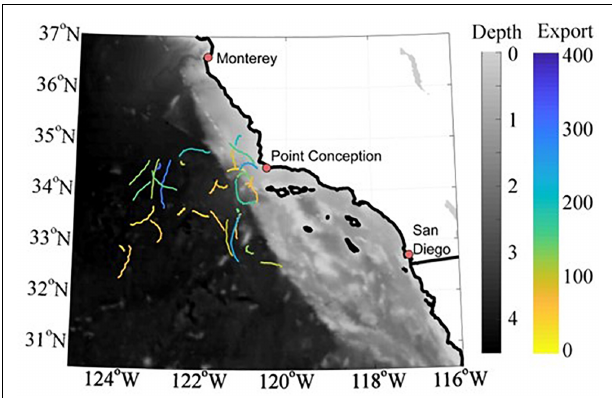
FIGURE 1 | Map of study region with bathymetry shown in gray scale and Lagrangian cycle tracks colored based on sediment trap measured export at a depth of 100 m (mg C m – 2 d – 1